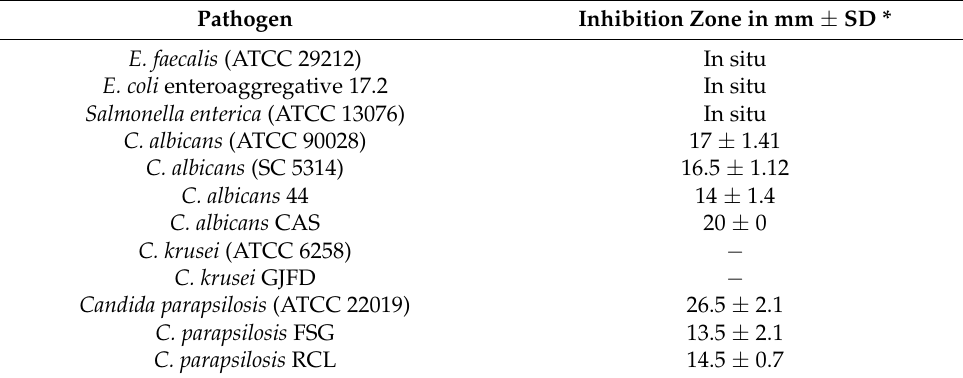
Table 6. Antagonism assay by the overlay method against L. fermentum ATCC 23271.